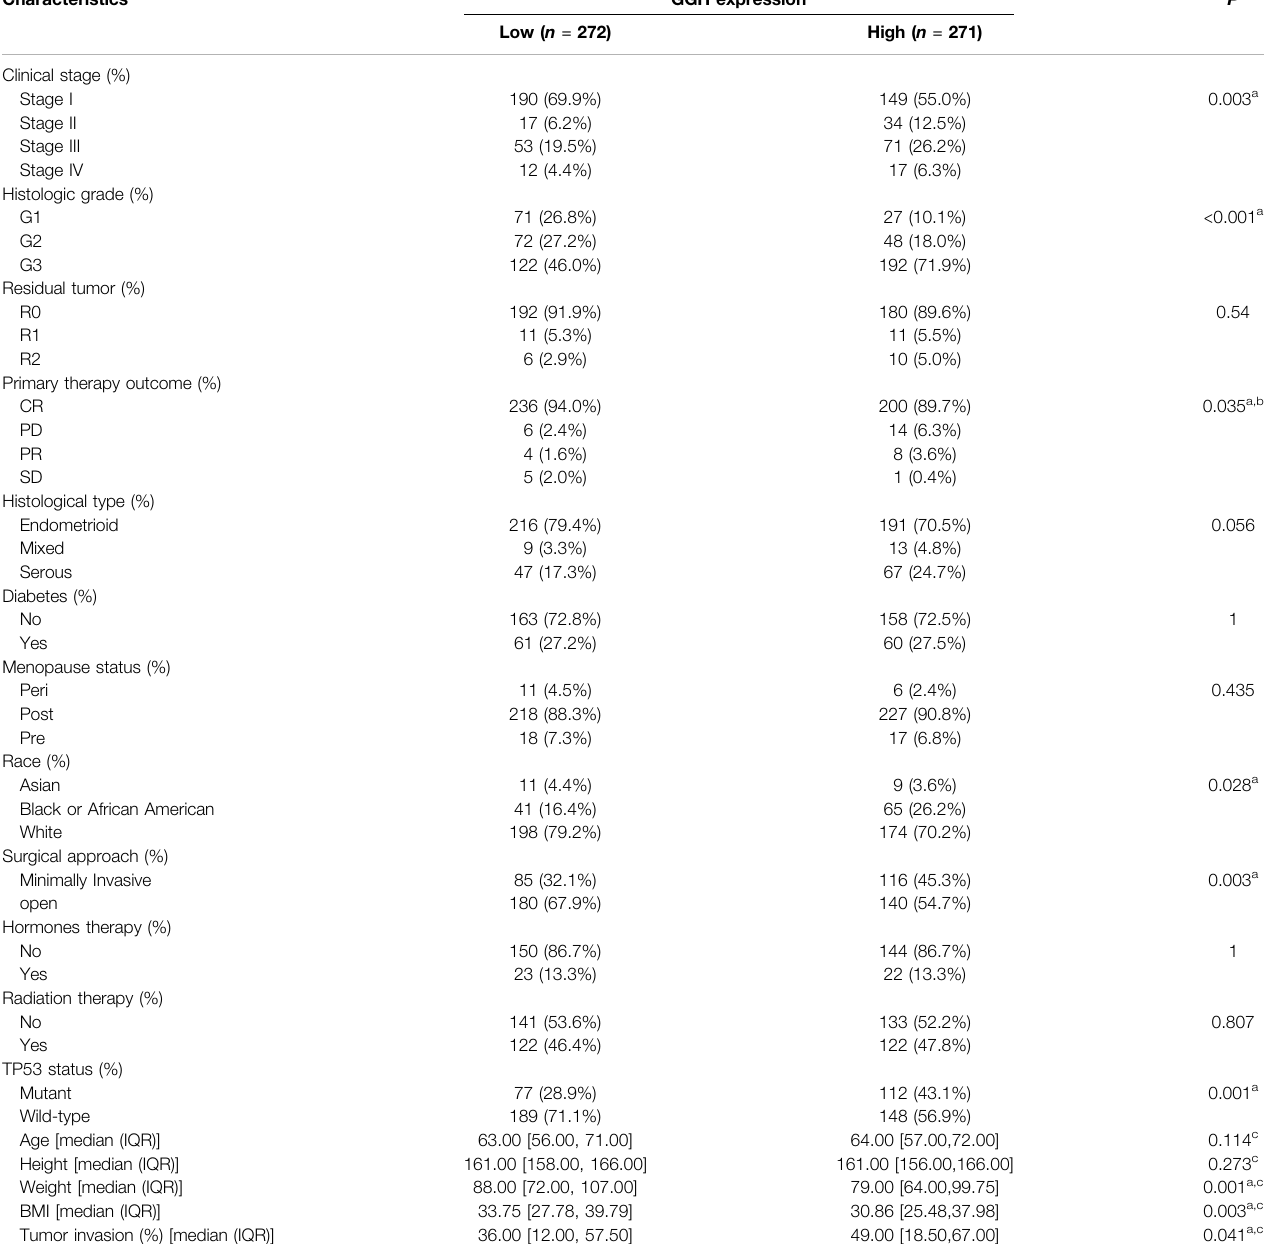
TABLE 1 | Associations between GGH expression level and clinicopathological features of UCEC.